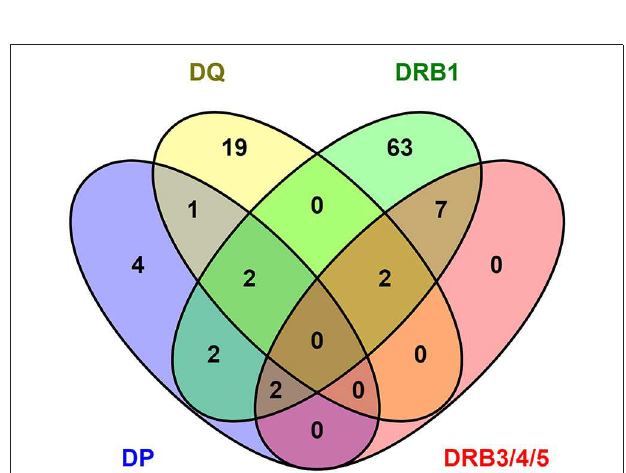
FIGURE 4 | DENV epitope overlap across HLA class II loci. The number of epitopes positive in more than one donor have been clustered using cluster 2.0 (35) (http://tools.iedb.org/cluster2/) and shown as Venn diagram using Venny 2.1